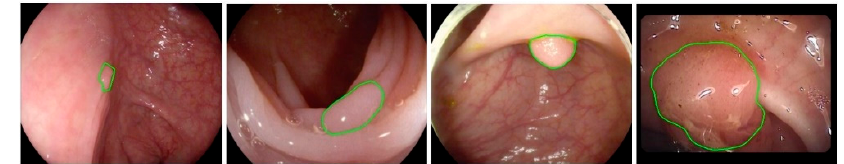
Figure 1. Images with ground truth polyps (marked in green) from colonoscopy videos.